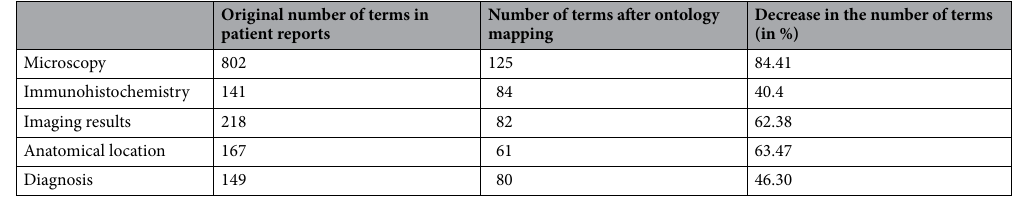
Table 2. Result of feature engineering using mappings to EpSO terms.